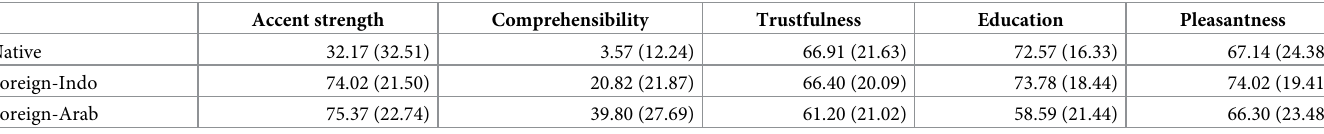
Table 5. Results of the perception of the native, the foreign-Indo and the foreign-Arab accent on a number of linguistic and social variables (0–100). Accent strength